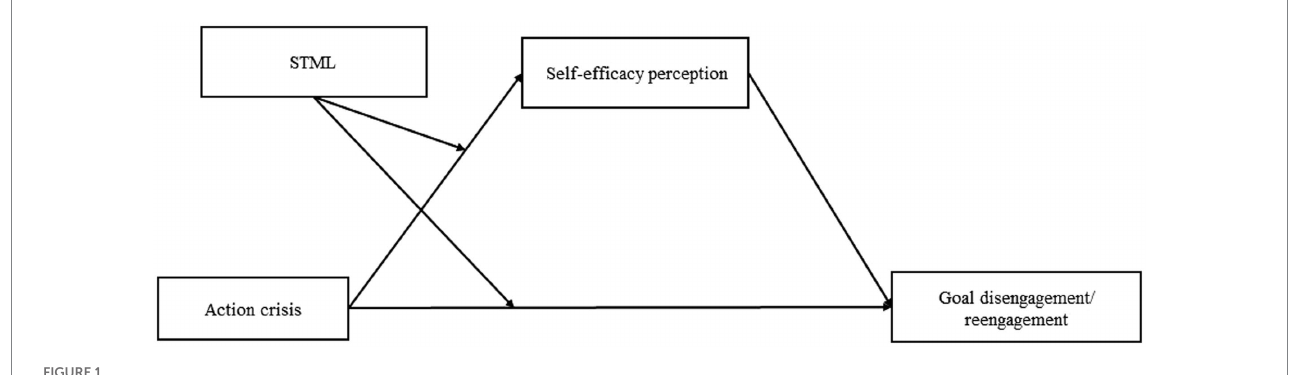
FIGURE 1 Conceptual models for the